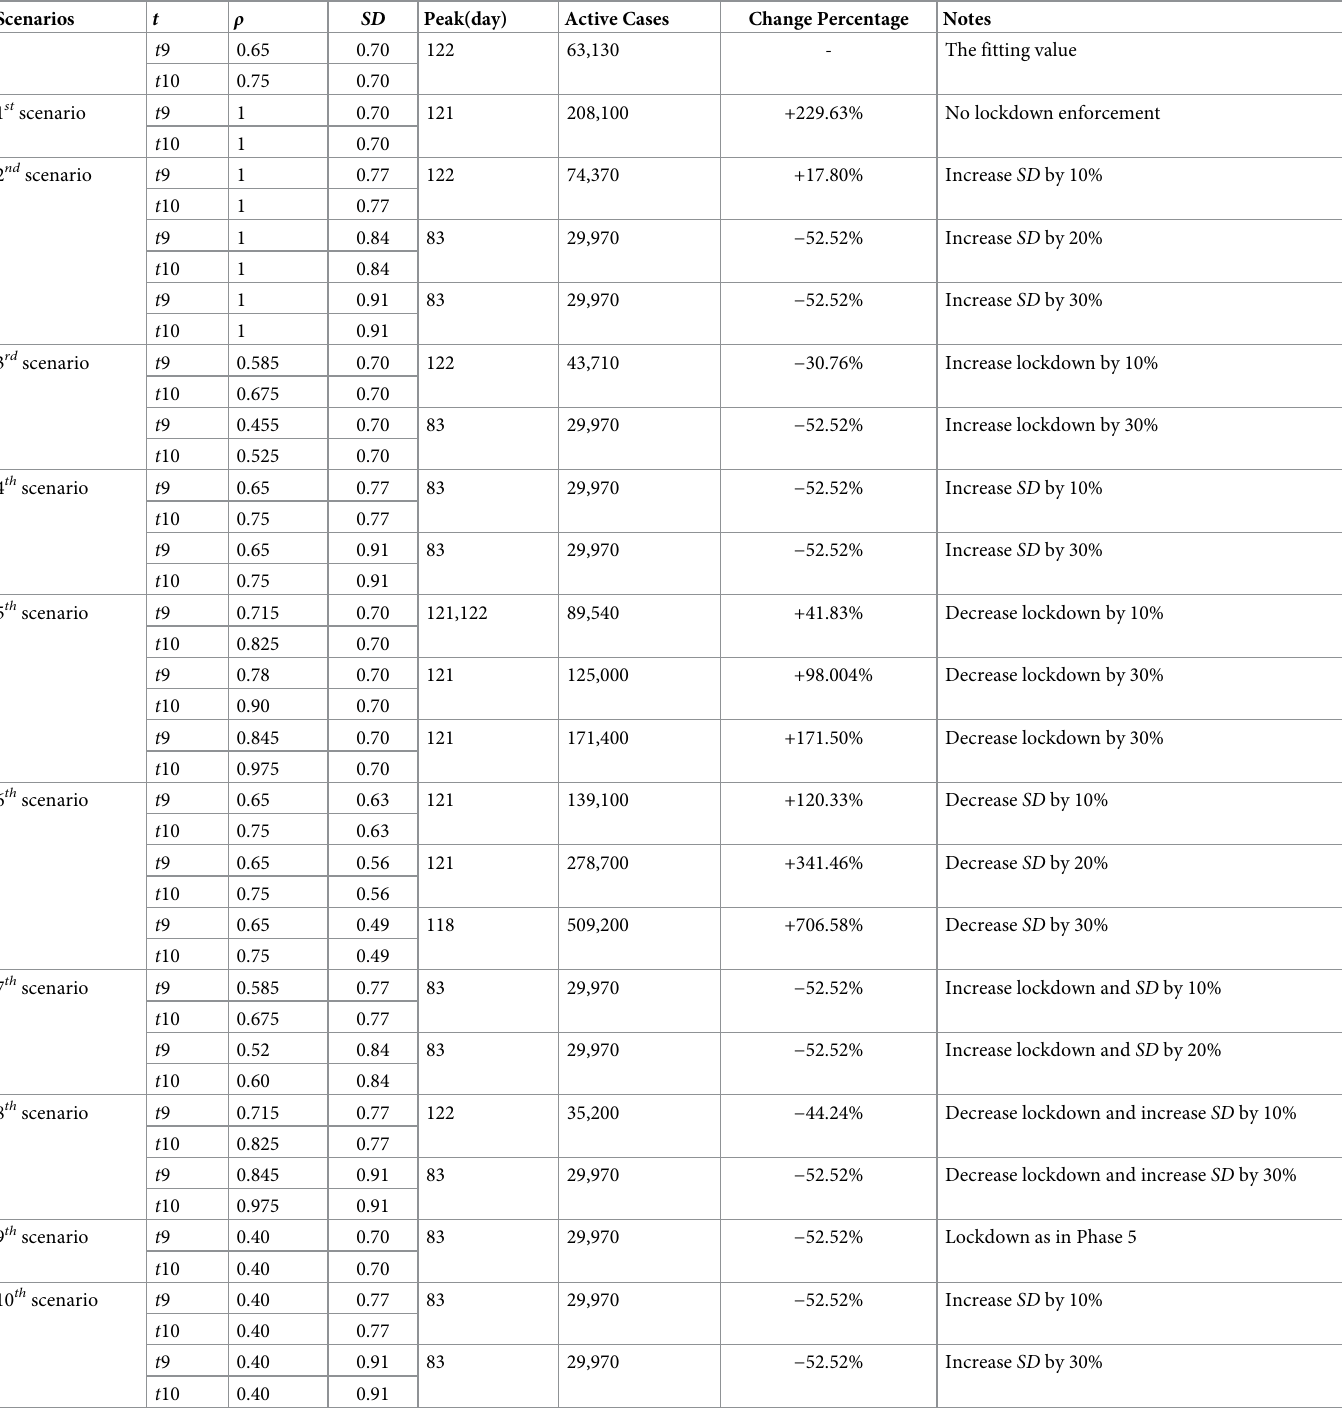
Table 10. Results of different scenarios for Phase